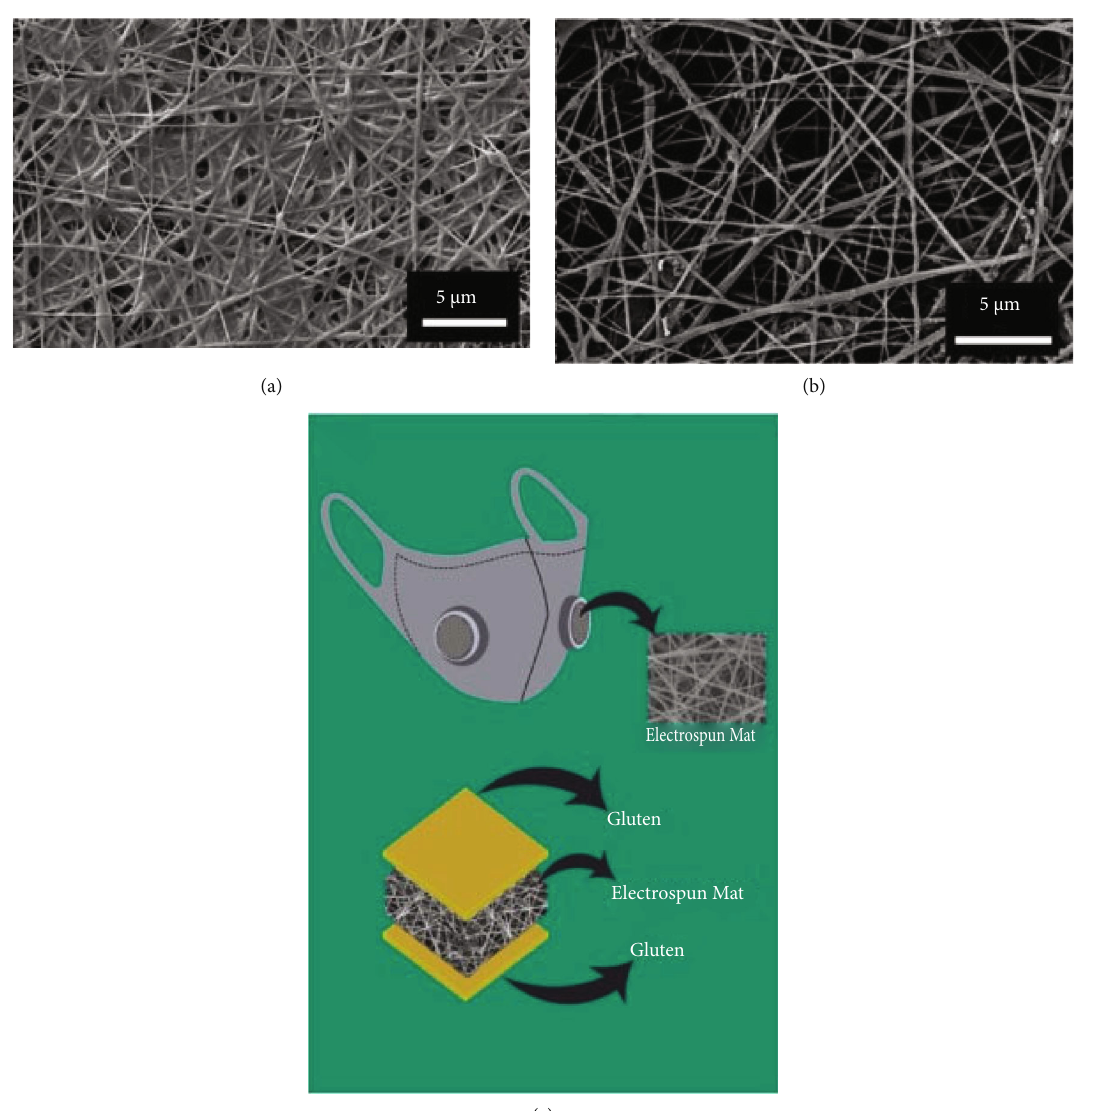
Figure 6: Face mask with electrospun fi brous sheet